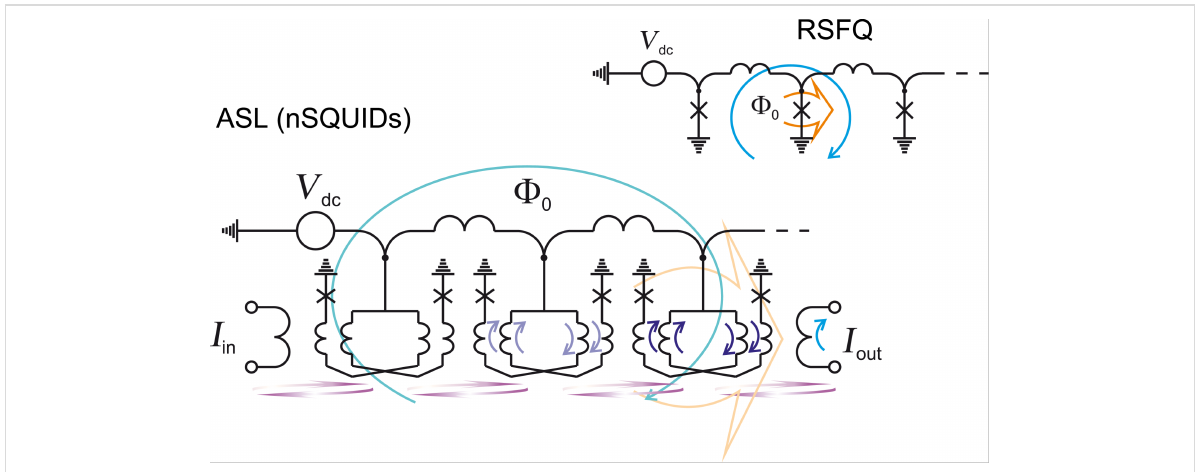
Figure 13: nSQUID-based adiabatic data bus and RSFQ data bus. Blue arrows show circulating currents, orange arrows highlight critically biased el- ements, violet arrows present magnetic